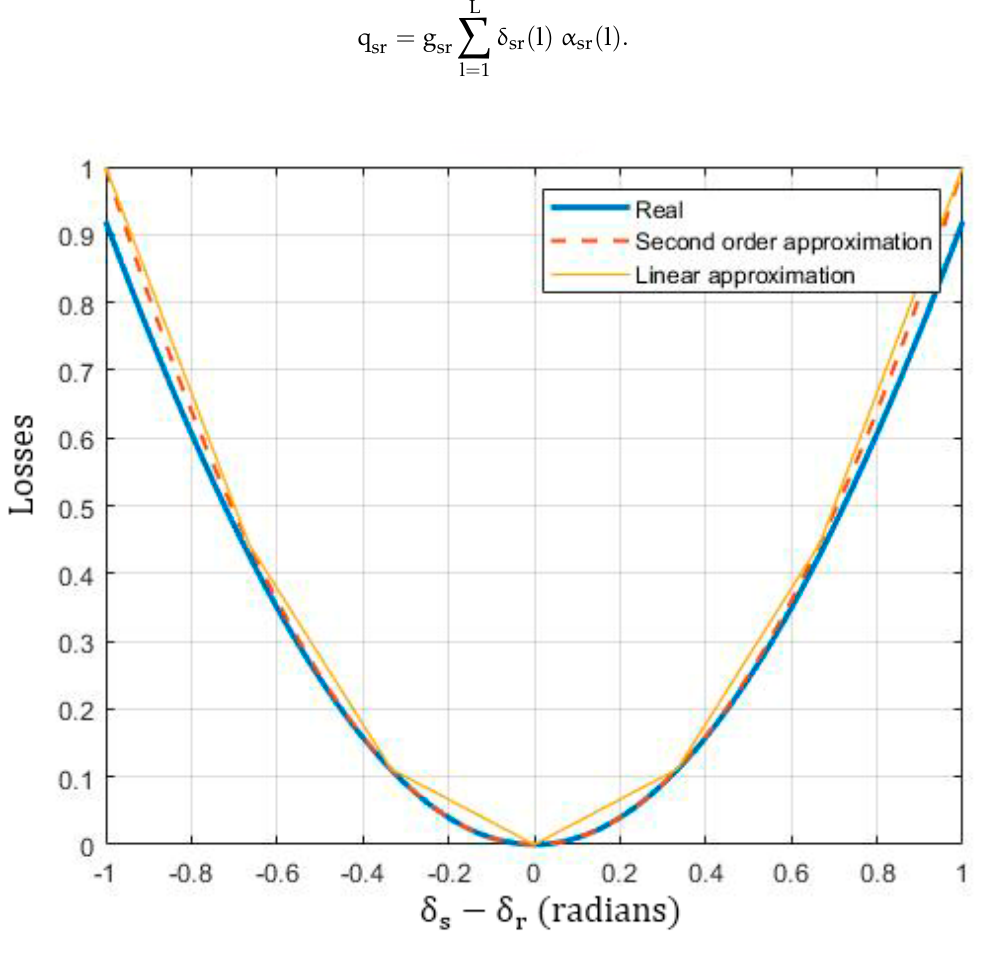
Figure 1. Approach for